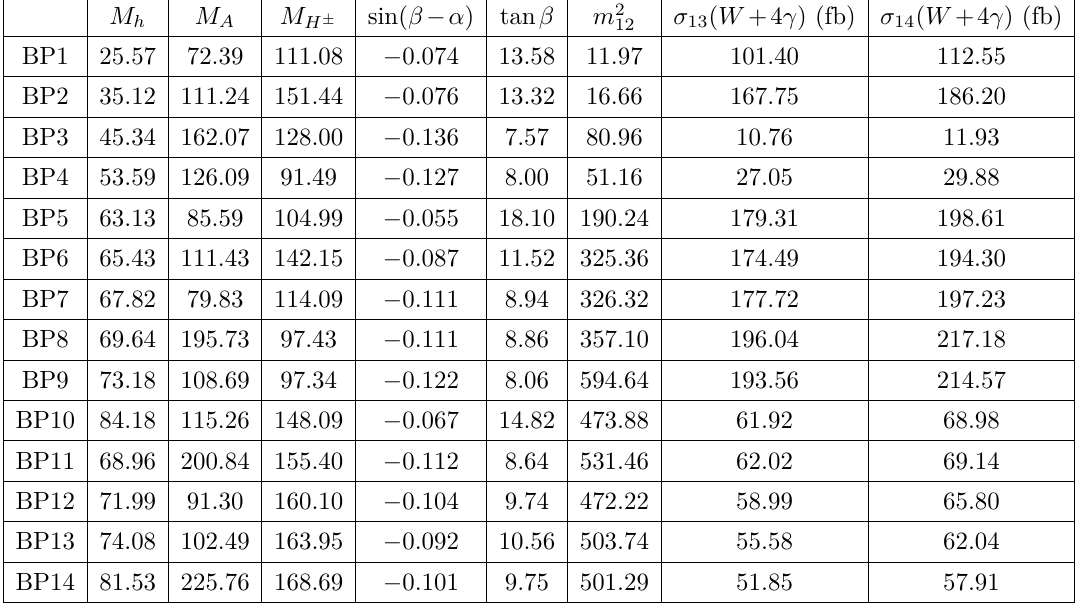
Table 3 . Input parameters and the Leading Order (LO) cross sections at the parton-level with √ s = 13(14) TeV for each BP are presented. All masses are in GeV and recall that M H = 125